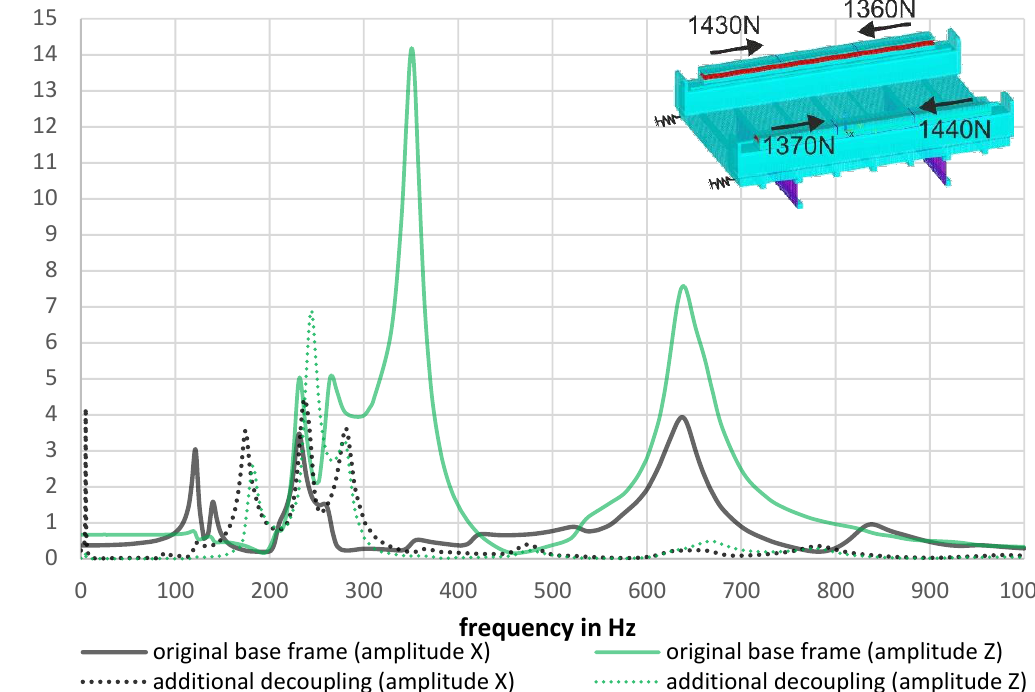
Figure 8. Frequency response of the frame vibration amplitude in X- and Z-direction (at the location of the accelerometer, see Figure 2), excited by opposing, non-identical drive forces (residual forces).